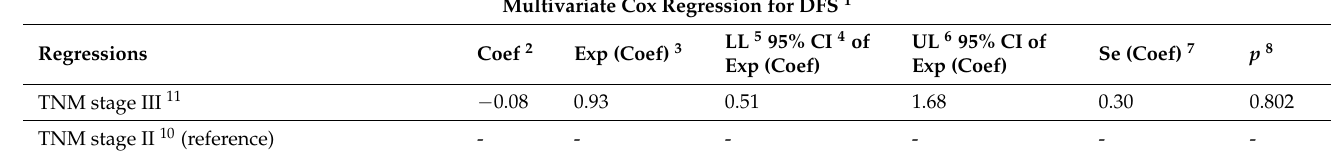
Table 2. Cont. Multivariate Cox Regression for DFS 1